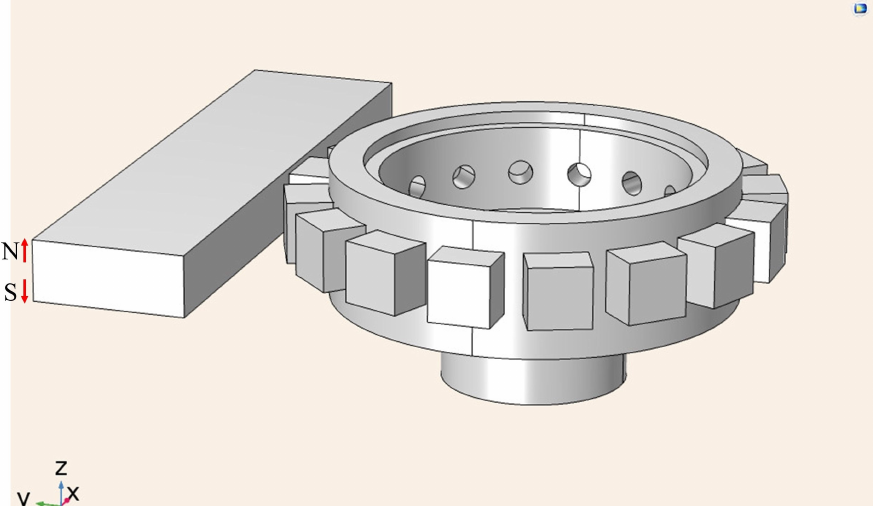
Figure 6. Simulation model of the thermomagnetic heat engine.